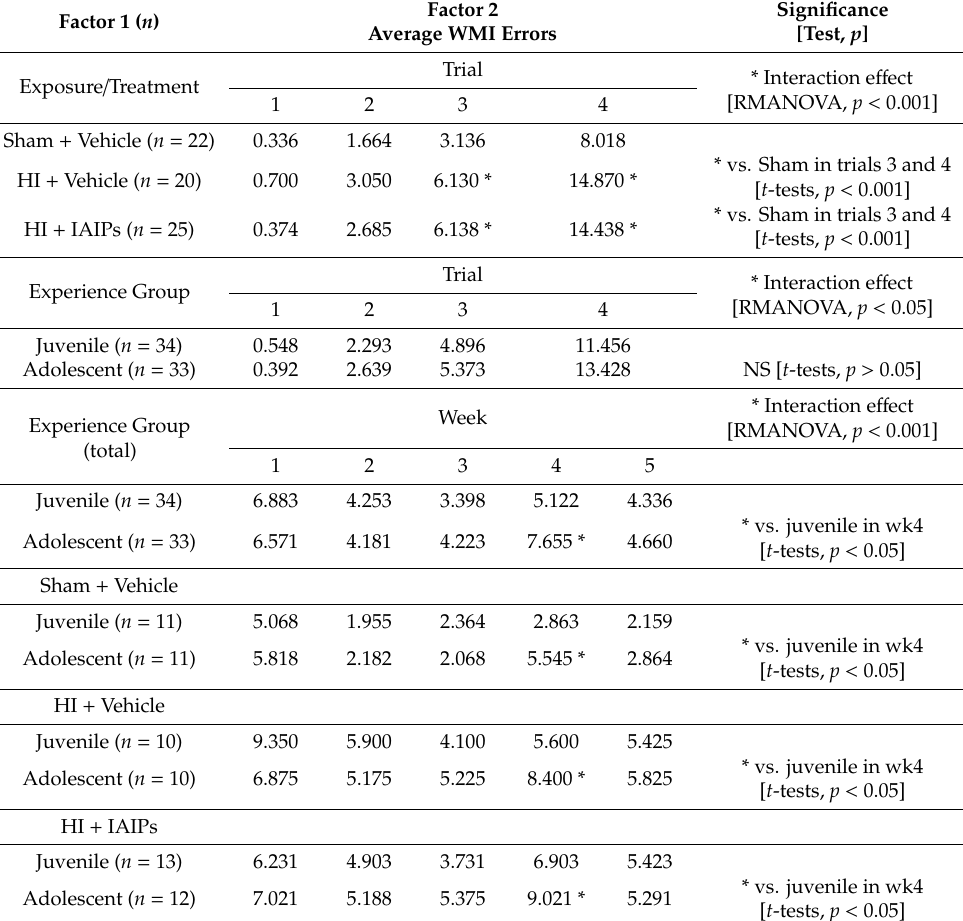
Table 2. Multifactorial interaction comparisons (repeated measure ANOVA) and simple means comparisons ( t -tests) of RWM errors. Sidak corrections used for t -tests with multiple comparisons. (* for a value indicates a significant paired di ff erence, see significance column, * in a column title indicates a significant overall or interaction e ff ect, as per